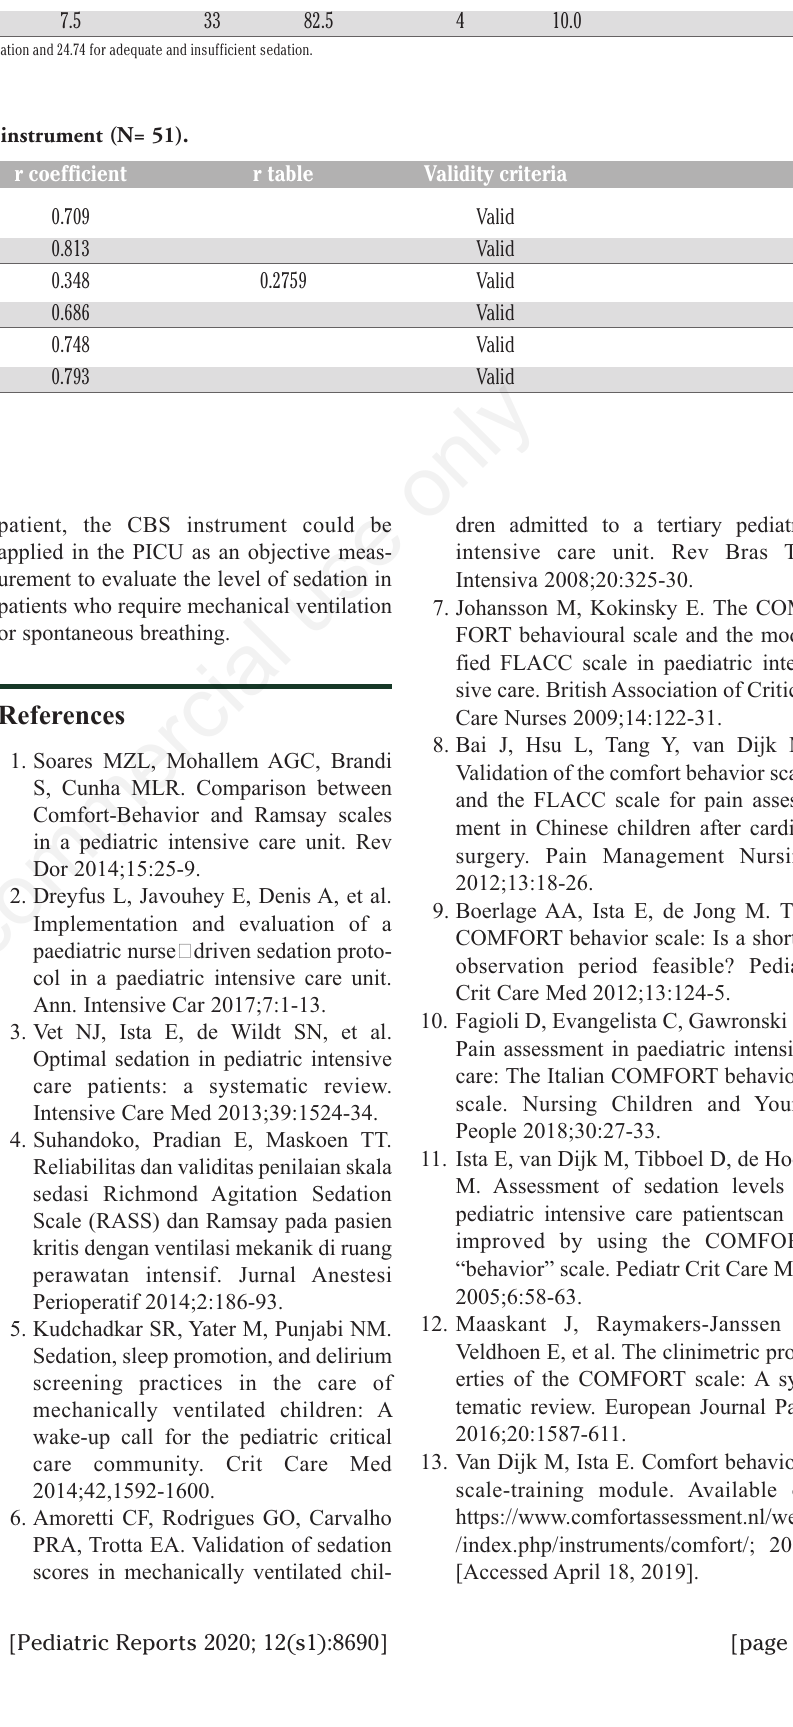
Table 4. The validity of each item of the CBS instrument (N= 51).